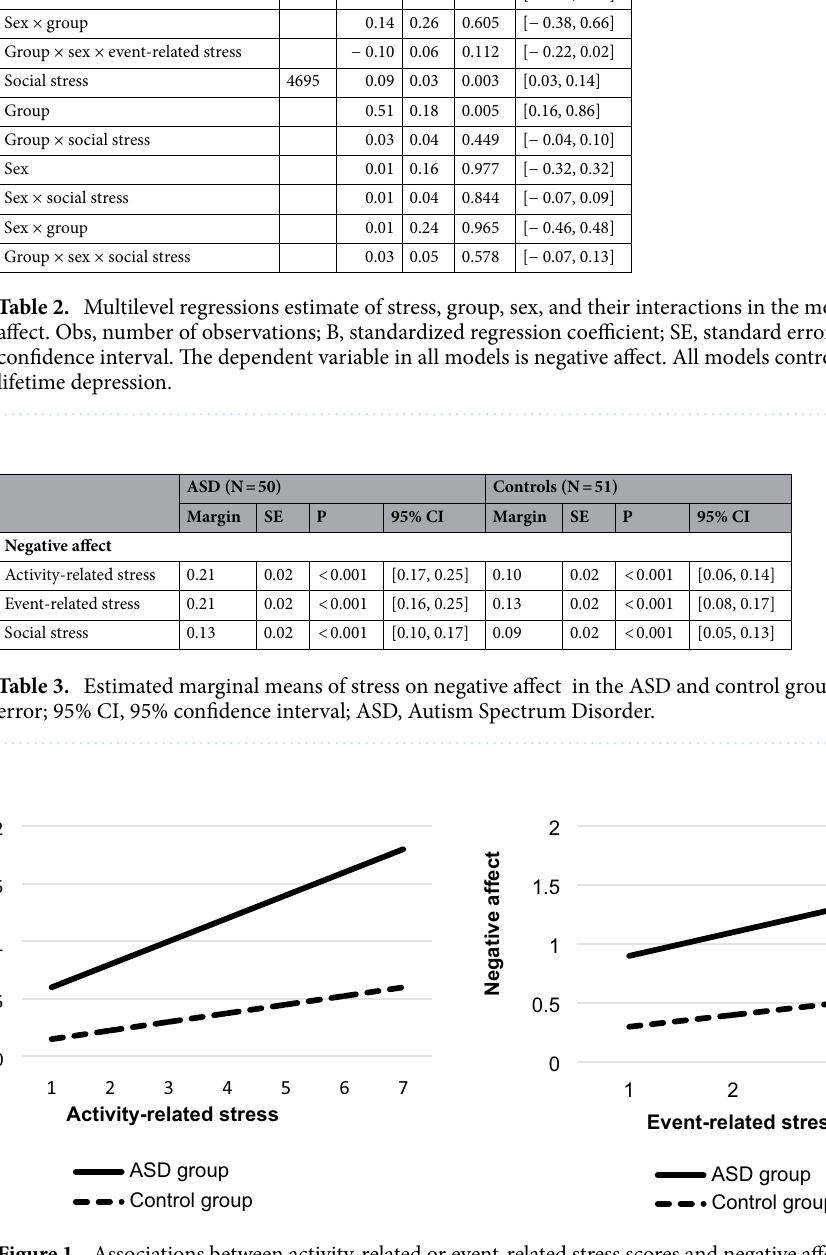
Figure 1. Associations between activity-related or event-related stress scores and negative affect. ASD, Autism spectrum